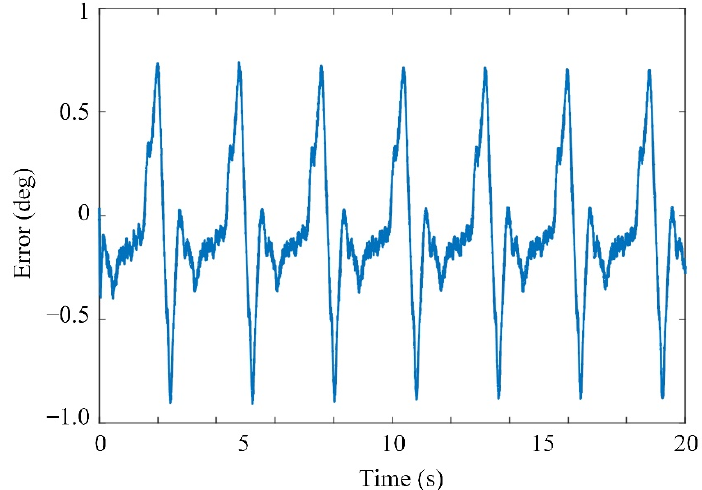
Figure 12. Tracking error.